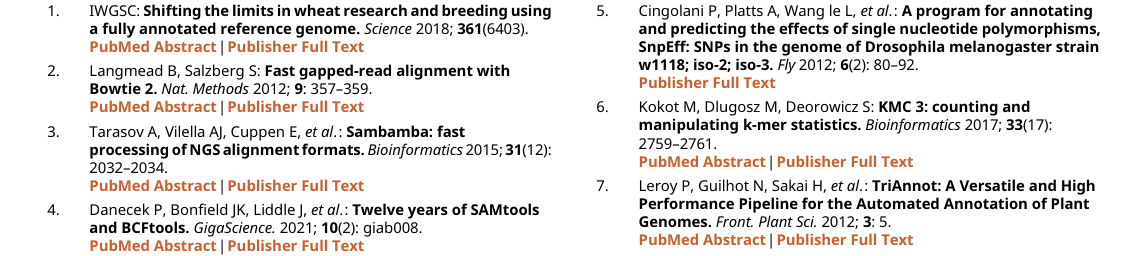
This project contains the following extended data: